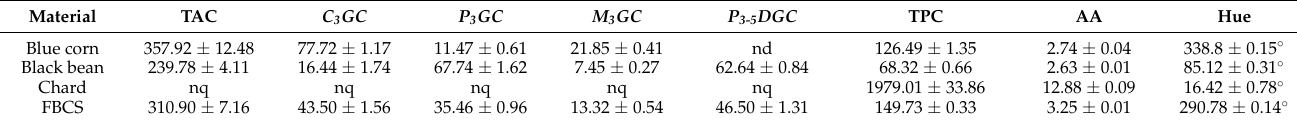
Table 4. Physicochemical properties of raw